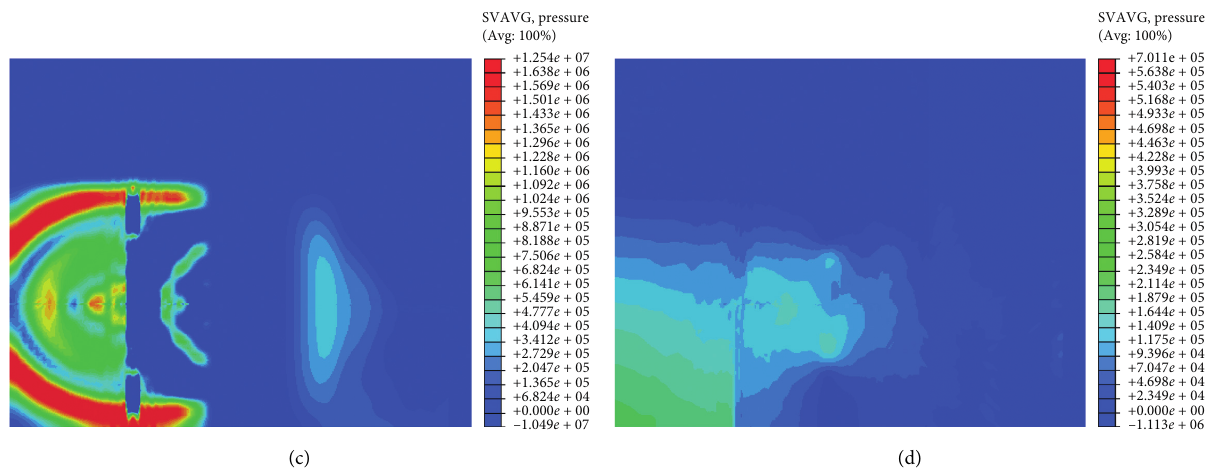
Figure 10: Stress nephogram of bubble wall weakening water hammer wave. (a) 0.05ms. (b) 4ms. (c) 8ms. (d) 20